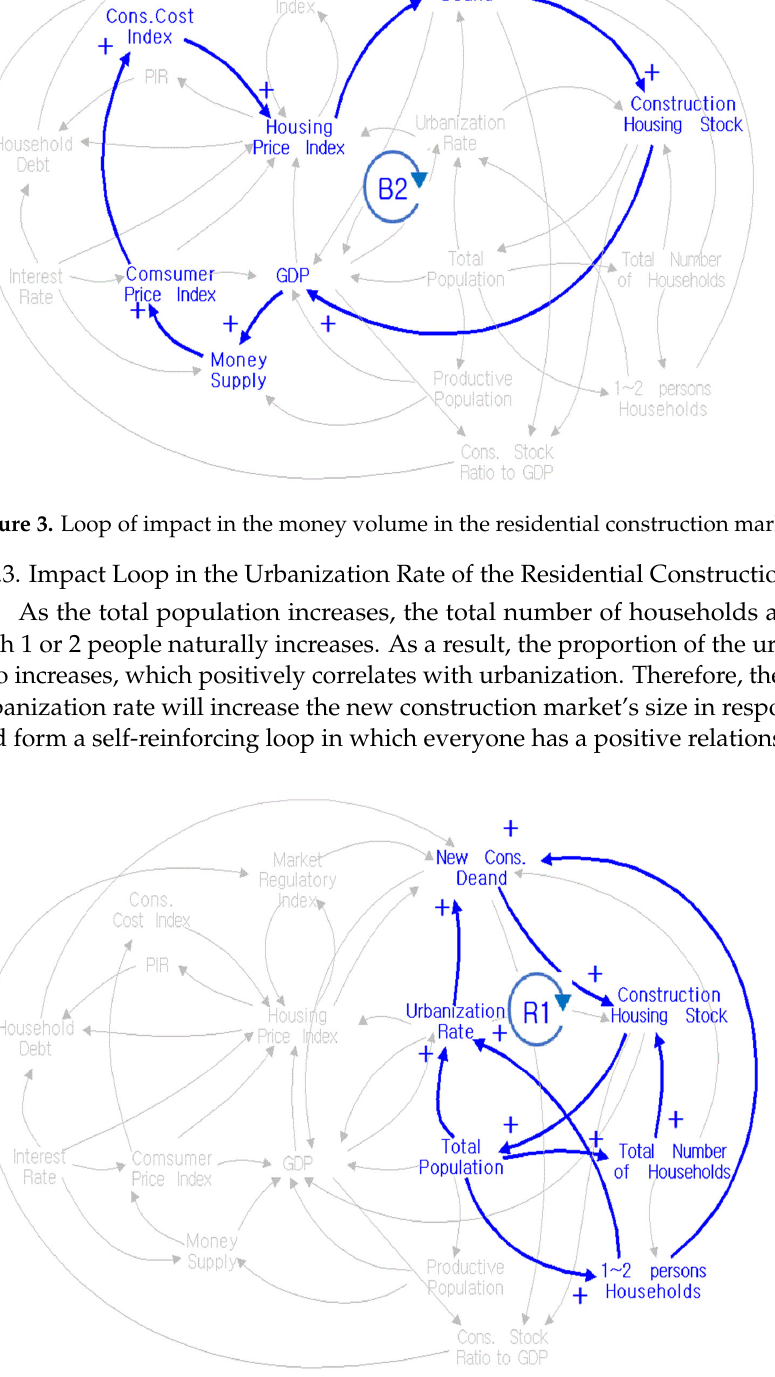
Figure 4. Effect of urbanization rate on residential construction